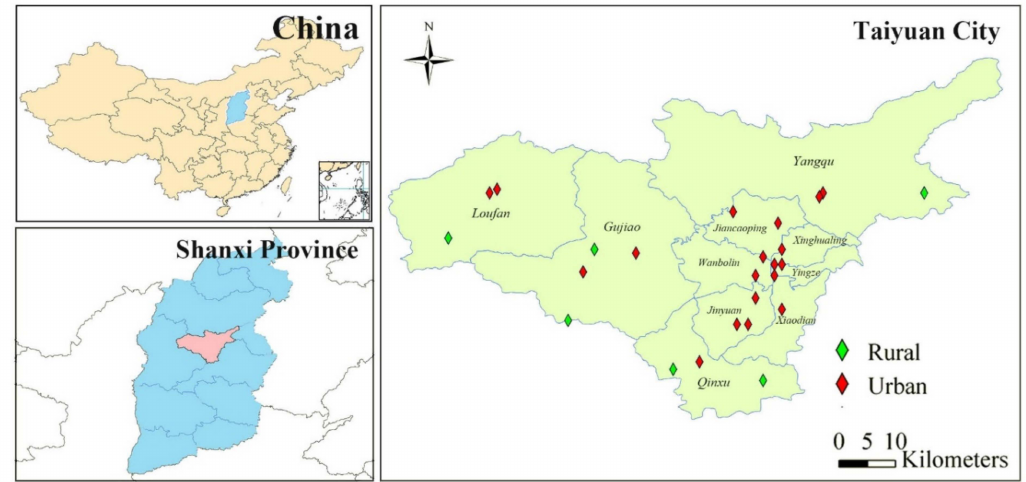
Figure 1. Atmosphere sampling sites in Taiyuan City. Six districts include Jiancaoping (JCP), Xinghualing (XHL), Wanbolin (WBL), Jinyuan (JY), Xiaodian (XD), and Yingze (YZ); four counties include Yangqu (YQ), Loufan (LF), Gujiao (GJ), and Qingxu (QX).